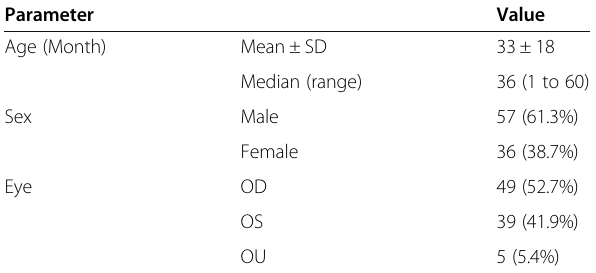
Table 3 Different pathogens in pediatric keratitis